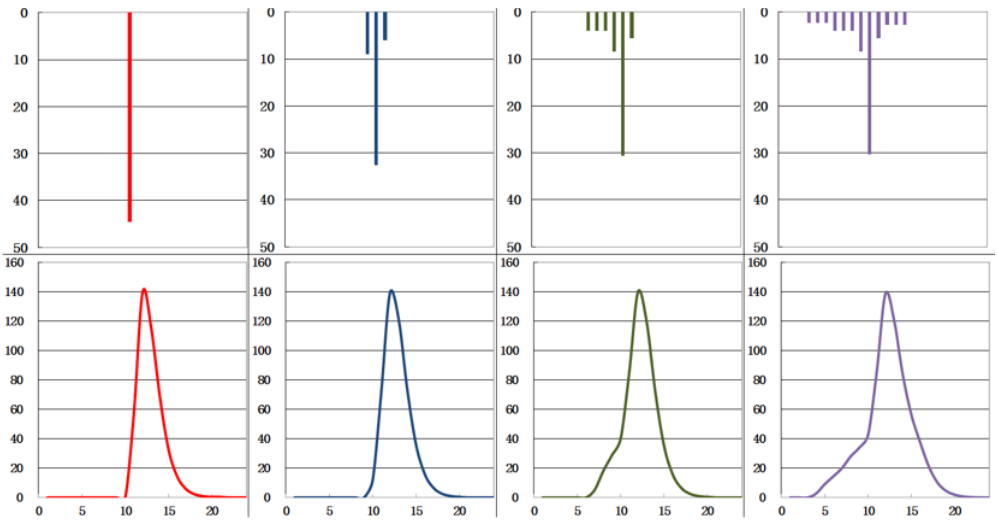
Figure 3. Schematic diagram of the back extrapolation of net rain threshold value.